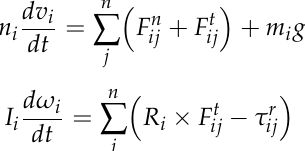
Figure 4. Types of stirring blades used in the simulation: ( a ) modified paddle, ( b ) screw-ribbon, ( c ) scrub paddle-shaped, and ( d ) screw conveyor.